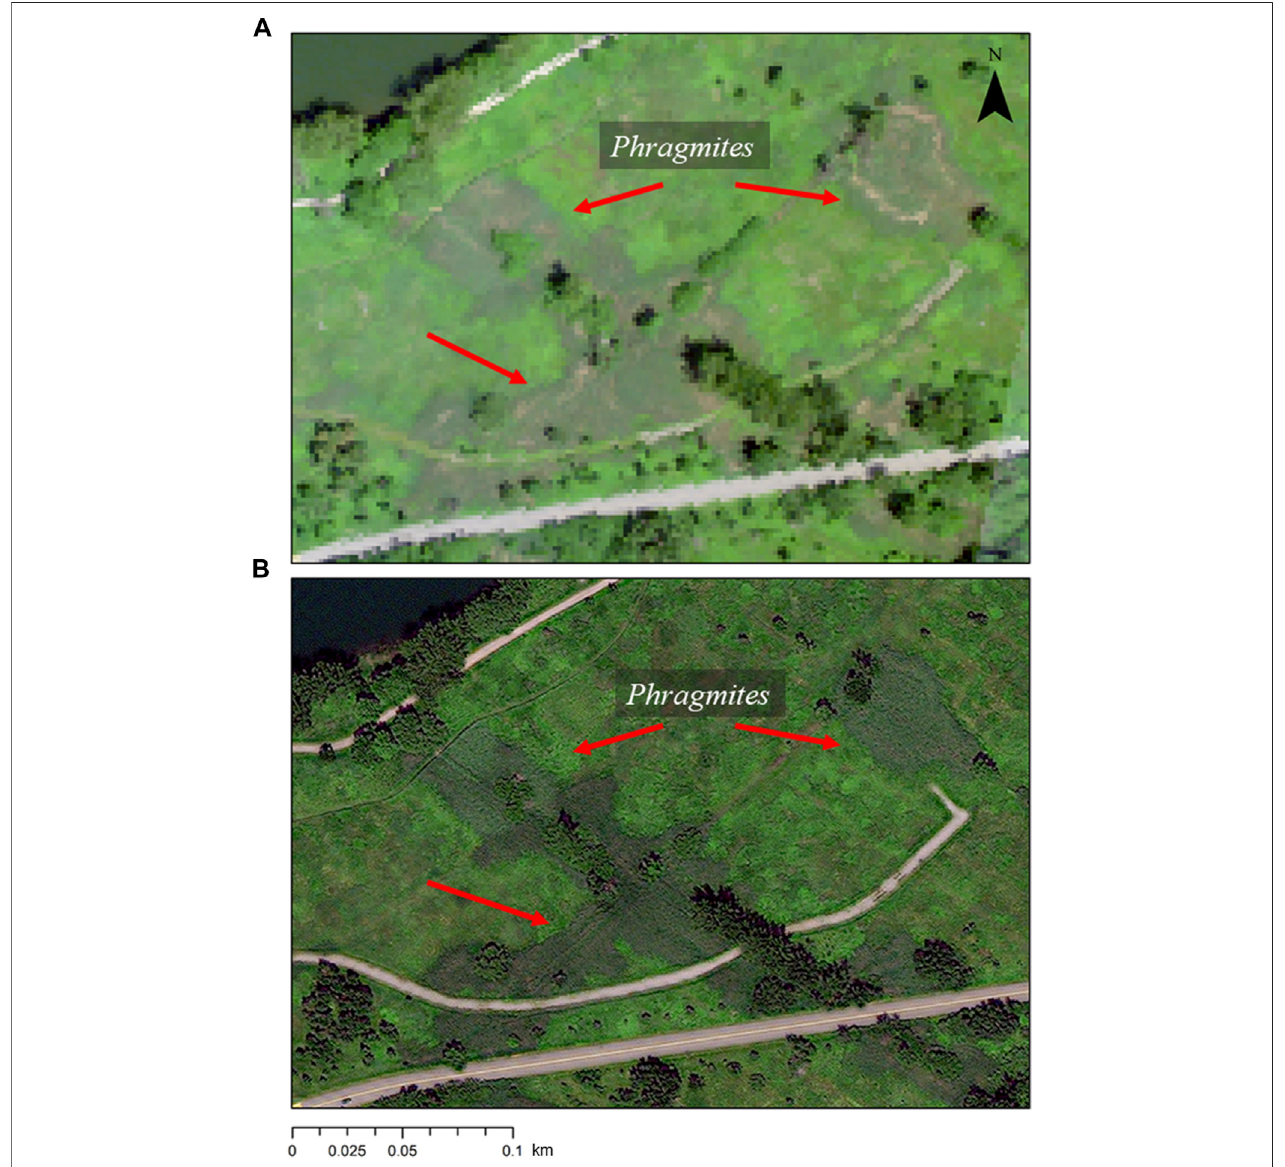
FIGURE 13 | An example of the difference in spatial resolution between the Satellite DMTI Streetview imagery used for (A) the visual interpretation (60 cm) and (B) the airborne HSI (2 m). The patches of darker vegetation are stands of Phragmites , as indicated by the red arrows.